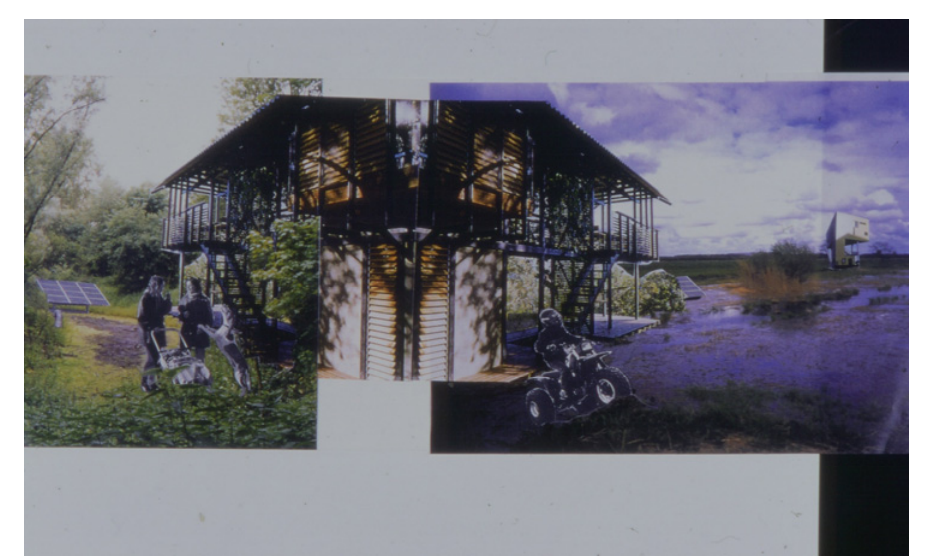
Figure 5. Light urbanism in the light city in Houten, the